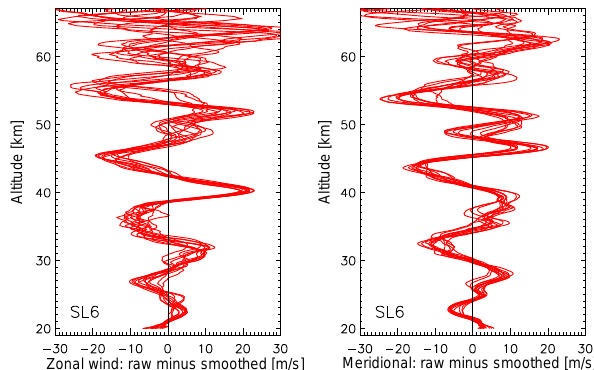
Figure 9. Wind profiles as measured by a single datasonde (SL6, red lines), the mean radiosonde profile (black line), and all DoRIS pro- files within a period of ± 20min around the datasonde flight (gray lines). Left: zonal winds, right: meridional winds.